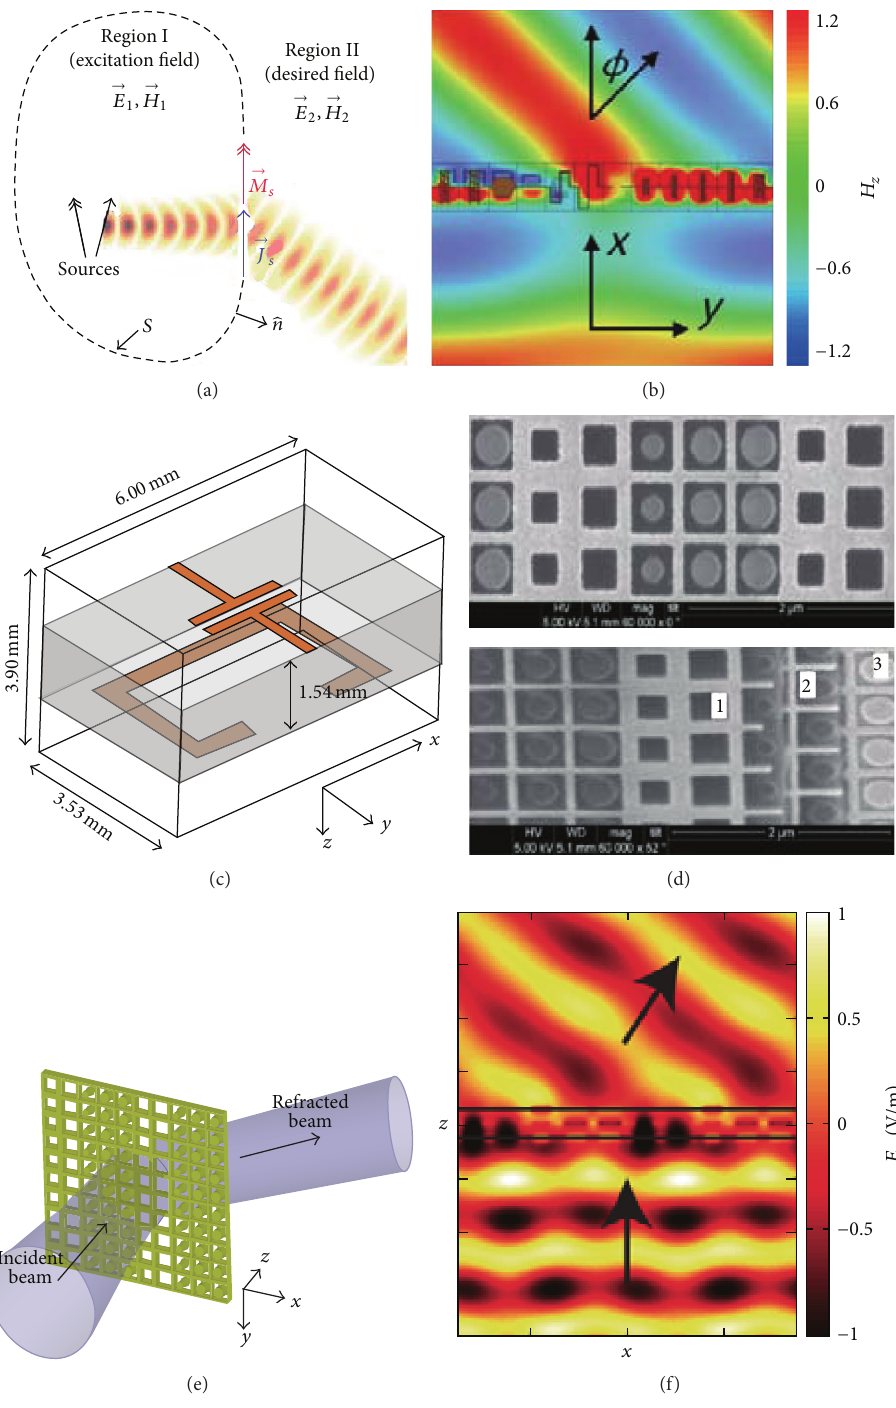
Figure 32: (a) Principle of the Huygens metasurface. The fields in regions I and II are defined independently of each other, and the surface equivalence principle is employed to find the fictitious electric and magnetic surface currents that satisfy the boundary conditions at the metasurfaces. (b) Simulated time snapshot of the magnetic field (Hz) of a 𝑦 -polarized plane wave, normally incident upon the designed Huygens’ surface. (c) Dimensions of the unit cells comprising Huygens’ metasurface. (d) SEM images of the optical Huygens’ surfaces. (e) Perspective view of an optically thin, isotropic Huygens’ metasurface that efficiently refracts a normally incident beam at telecommunication wavelengths. (f) Time snapshot of the steady-state, 𝑦 -polarized electric field when a plane wave is normally incident from the bottom at a wavelength of 1.5 𝜇 m. The incident electric field has an amplitude of 1V/m. Figures are reproduced from [176,